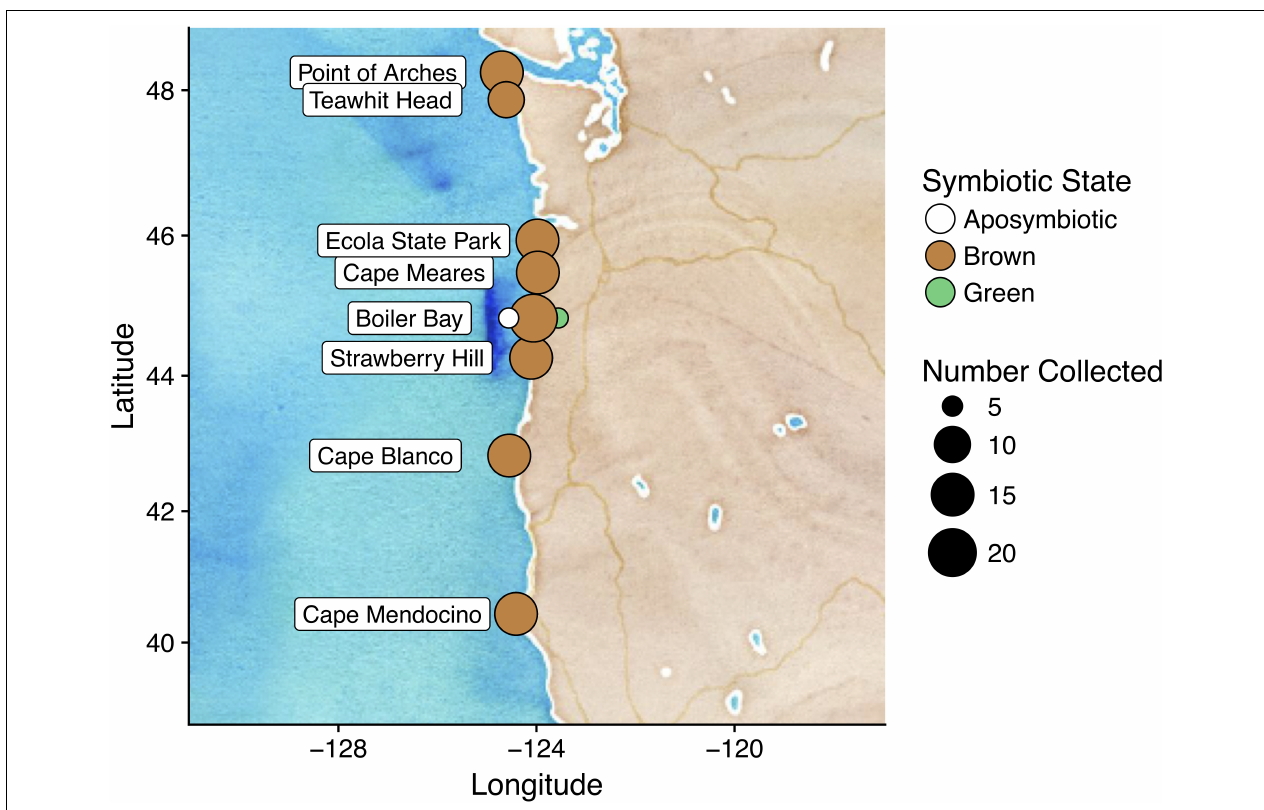
FIGURE 1 | We collected A. elegantissima from eight sites in the Pacific rocky intertidal over a latitudinal range of eight degrees. We returned to Boiler Bay to collect samples for analyses concerning symbiotic